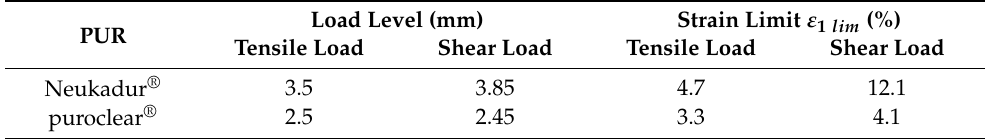
Table 4. Strain limits ε 1 lim determined using the mechanical test method for Neukadur ® and puroclear ® under tensile and simple shear load.